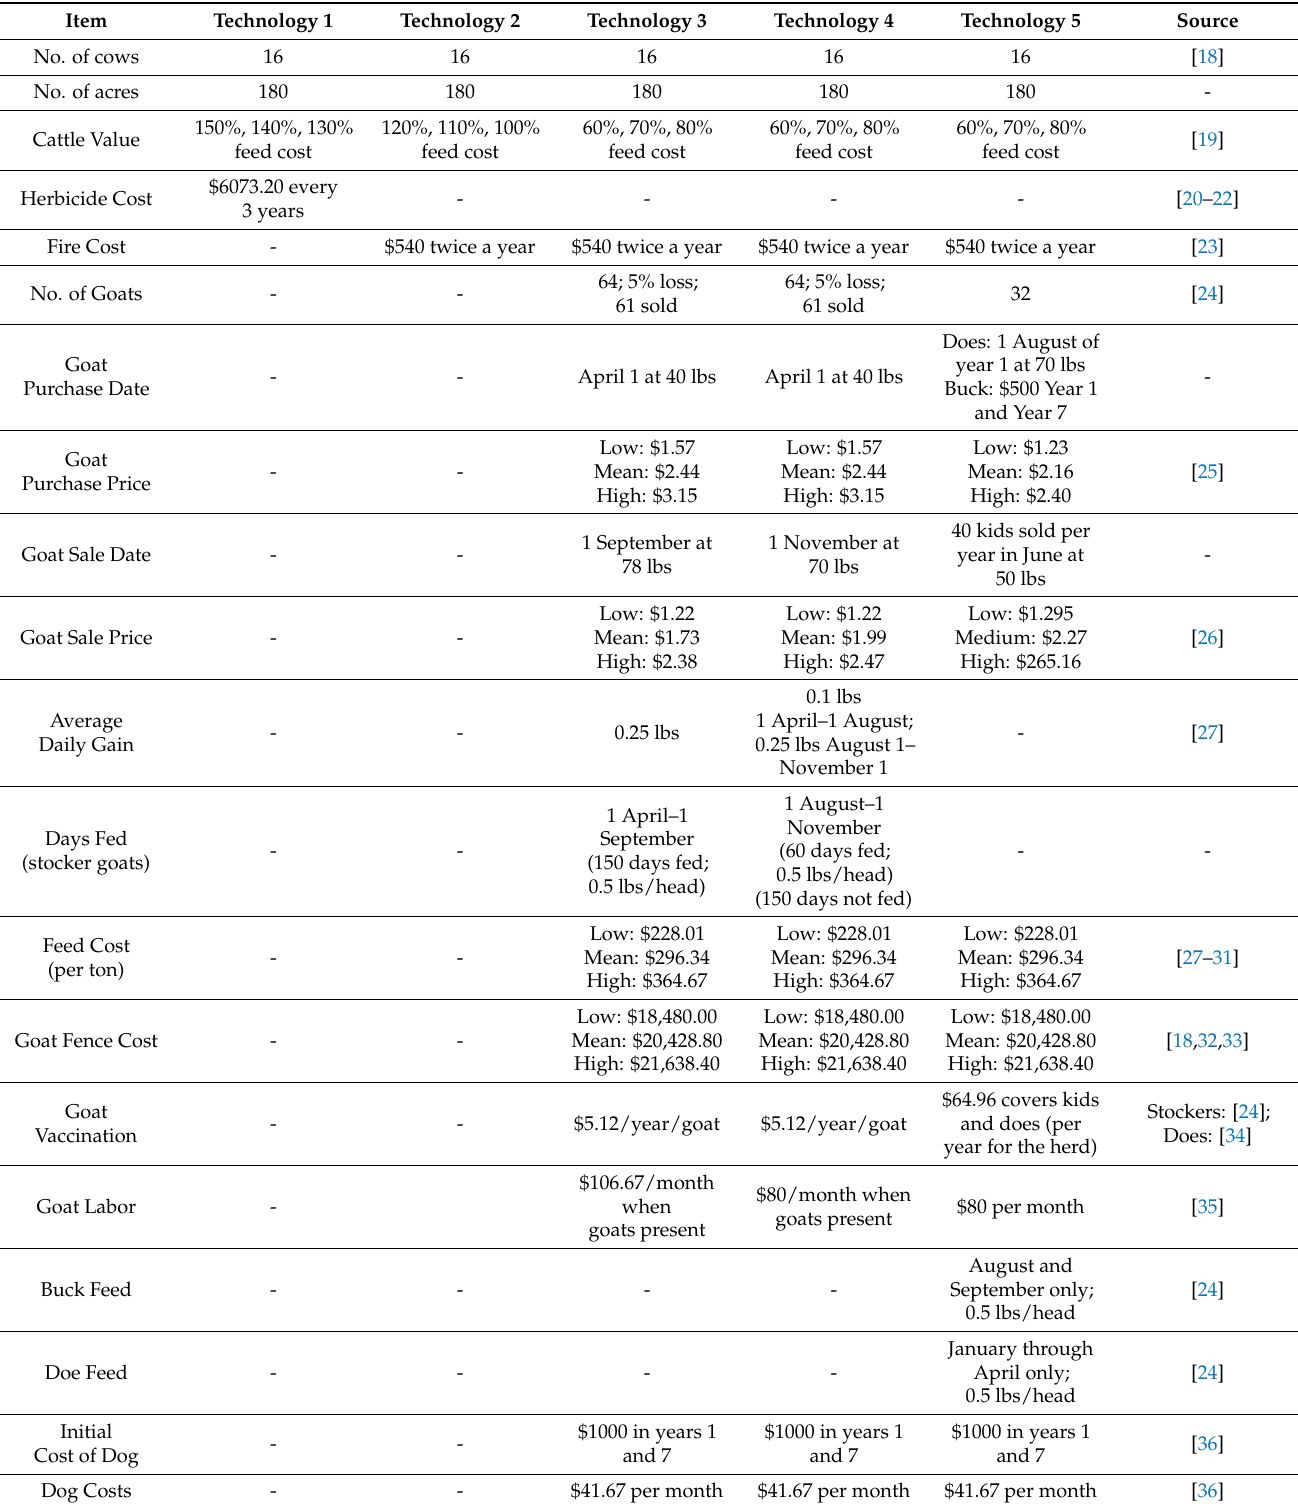
Table 1. Assumptions for the cost benefit analysis of the 5 technologies. (1) The standard woody plant control method with cattle grazing, (2) use of prescribed fire with cattle grazing, (3) use of fire, stocker goats and cattle grazing with goat feed supplementation during the entire season, (4) use of fire, stocker goats and cattle grazing with goat feed supplementation in the late season only and (5) the use of fire, breeding goats and cattle grazing with goats only supplemented when necessary for